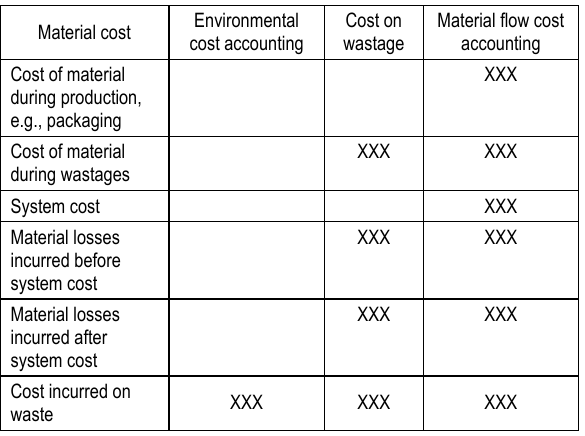
Table 1. Hypothetical expression of MFCA approach